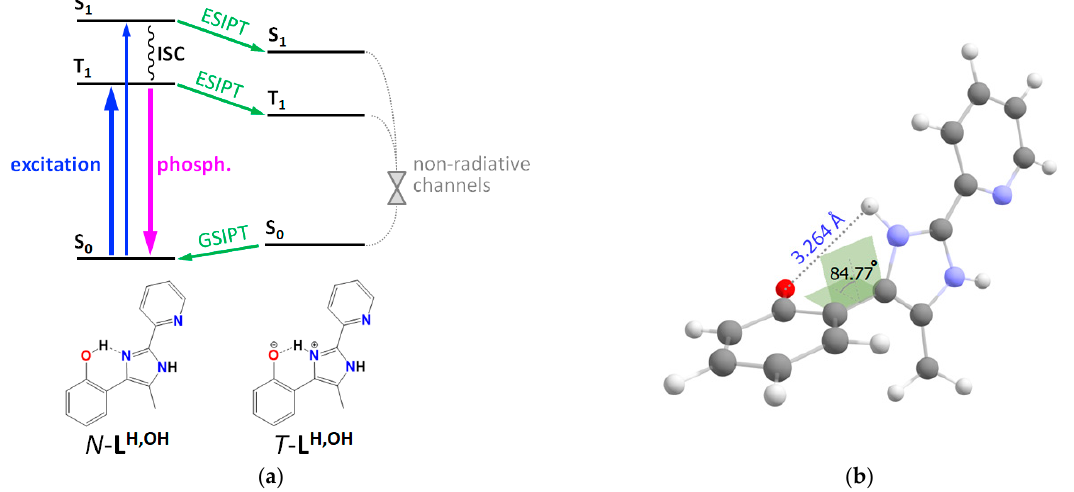
Figure 9. ( a ) Photophysical and photochemical properties of L H,OH in the solid state summarized in a simplified energy level diagram. ISC—intersystem crossing, phosph.—phosphorescence. ( b ) The geometry of L H,OH that is close to the conical intersection between the S 0 and S 1